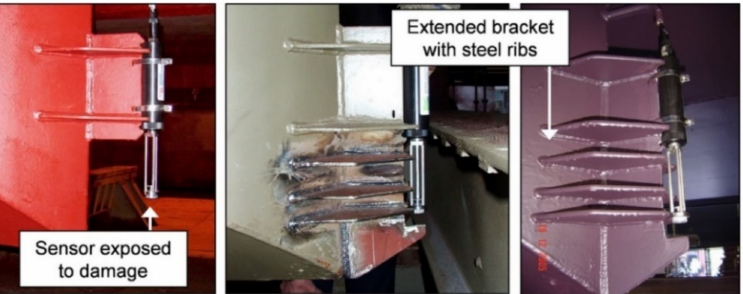
Figure 12. The first technical solution to increase the protection of sound velocity